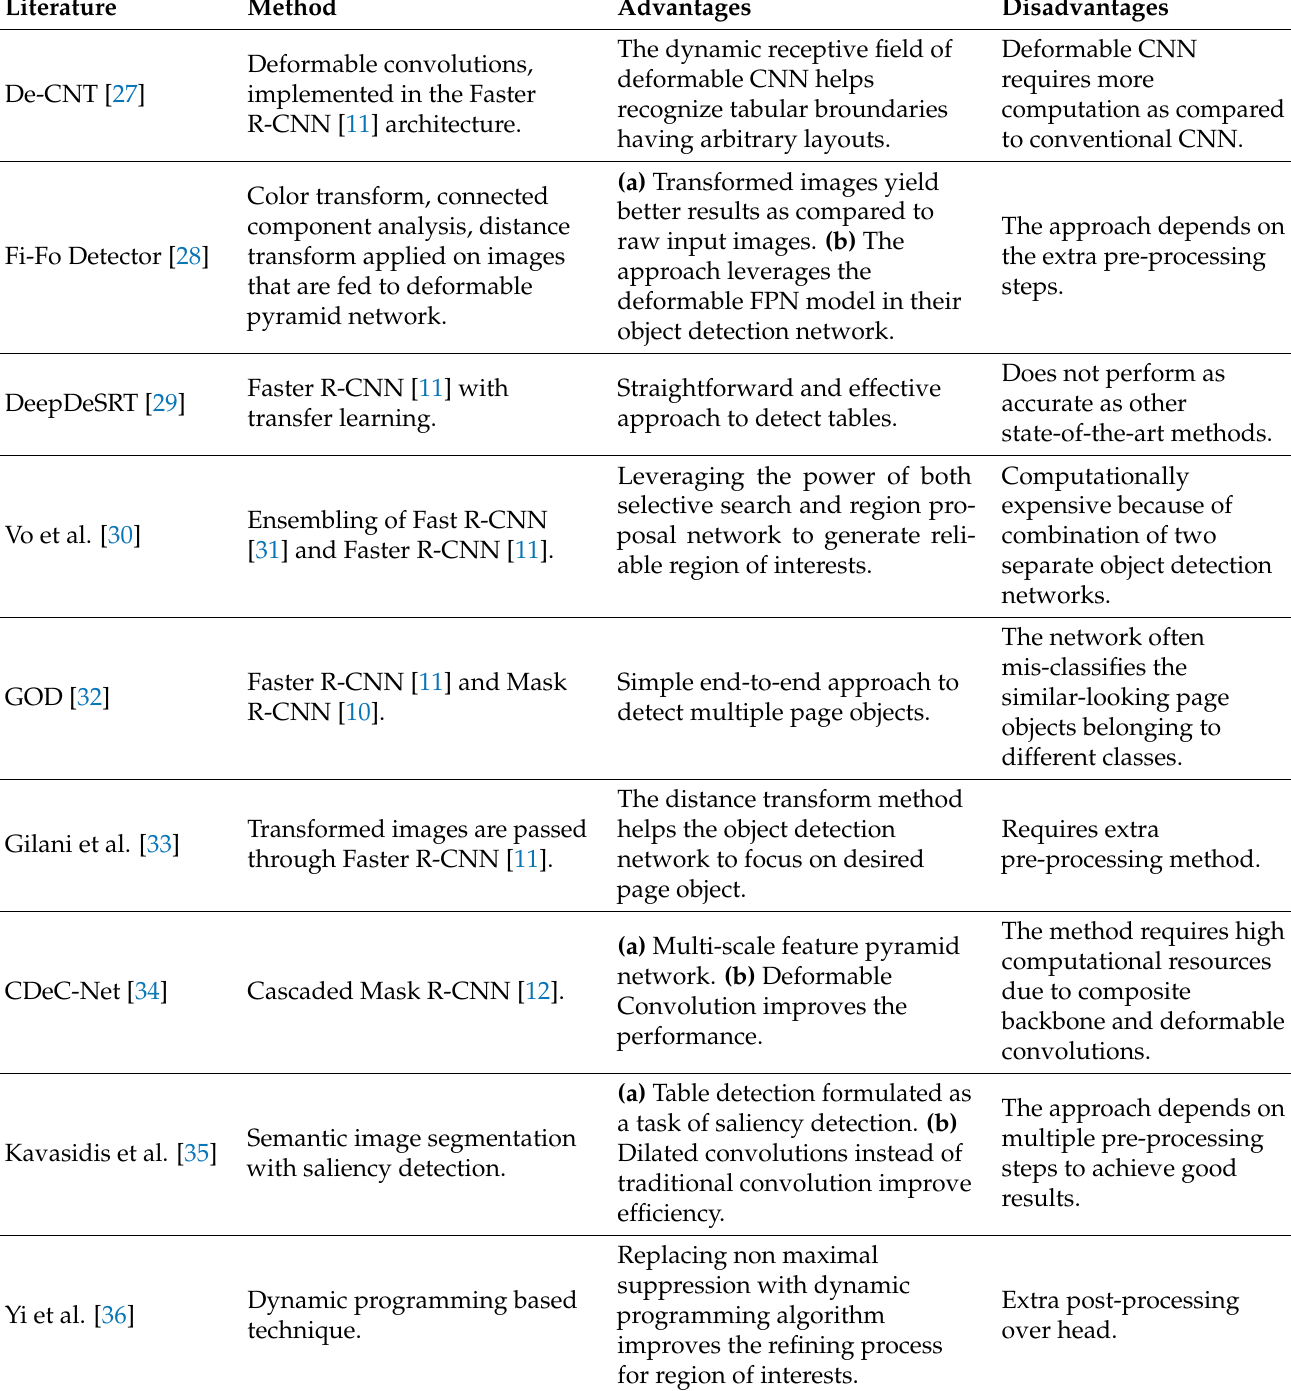
Table 1. A Summary of different graphical page object detection methods that have employed deep neural